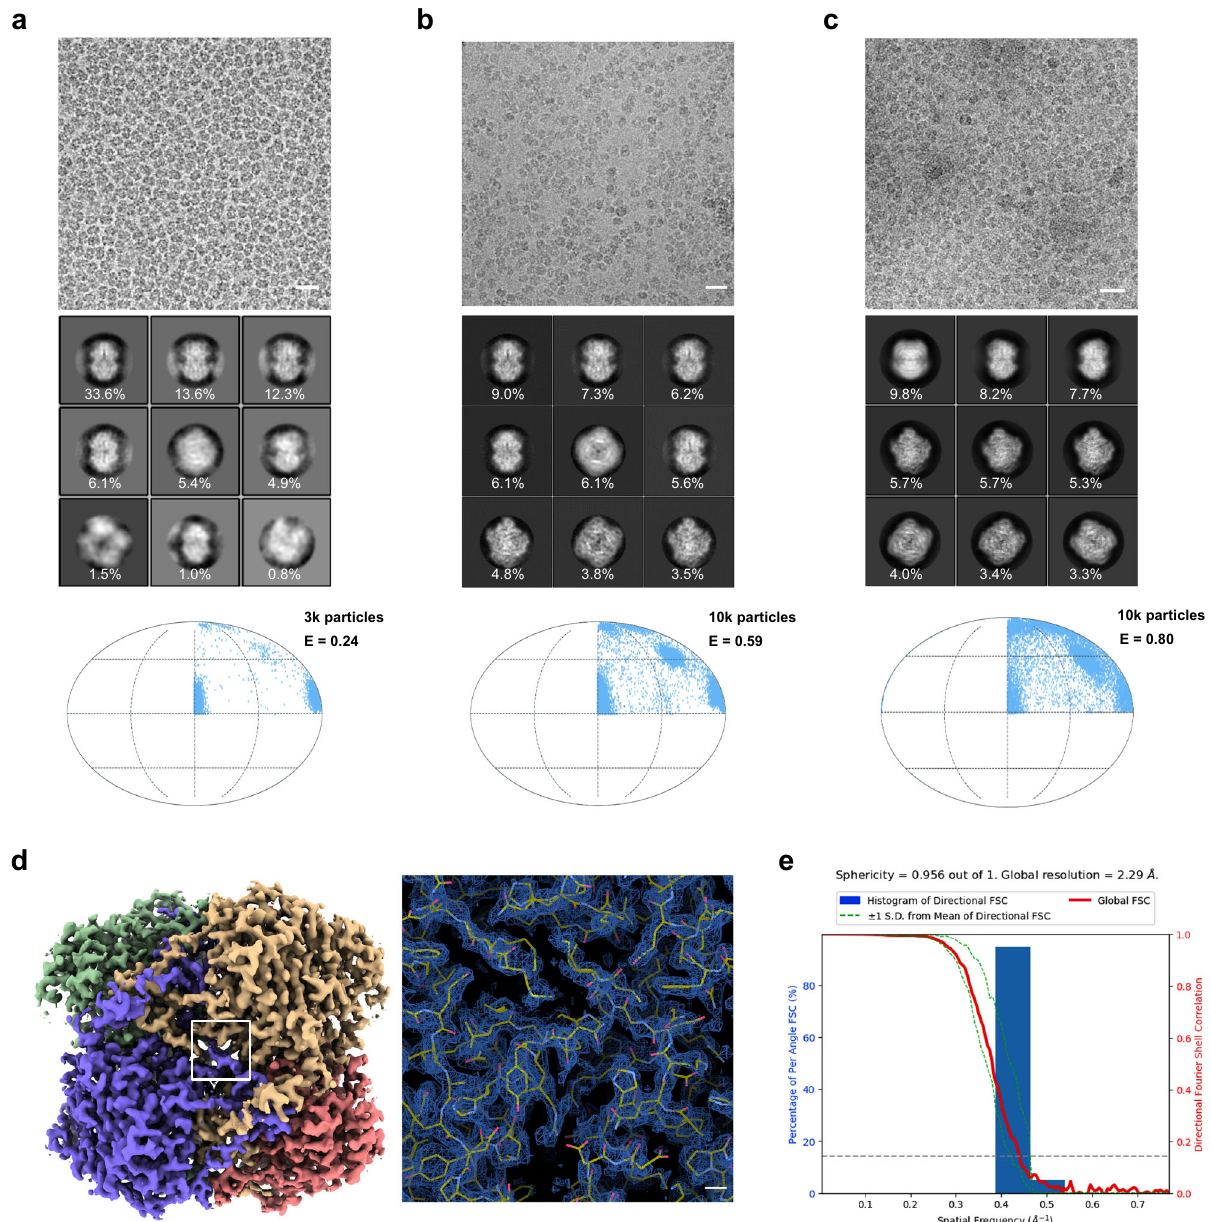
Fig. 3 Using HFBI fi lm to solve the preferred orientation problem of catalase. a – c Representative cryo-EM micrographs (scale bar, 20 nm) of catalase vitri fi ed using the ANTA foil grid in thin ice ( a ), in thicker ice ( b ) and vitri fi ed using the HFBI fi lm covered ANTA foil grid ( c ). The corresponding representative 2D class averages of catalase are shown in the middle. The percentage of the number of particles in each class is labelled accordingly. The computed orientation distributions with the cryo-EF values are shown at the bottom. The number of particles used to calculate the cryo-EF values is indicated accordingly. d Cryo-EM map of catalase at a resolution of 2.29 Å that was solved using the HFBI fi lm-covered ANTA foil grid. A representative region of the cryo-EM map is magni fi ed (right) with the fi tted atomic model. Scale bar, 2 Å. e 3D-FSC plot of cryo-EM reconstruction of catalase using the HFBI fi lm covered ANTA foil